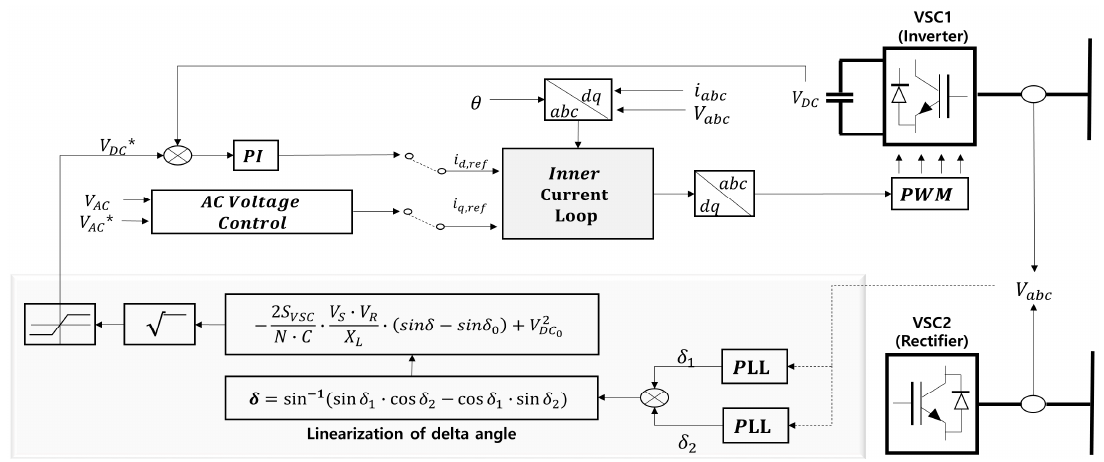
Figure 6. The second ATEC strategy structure with DC-link capacitors.